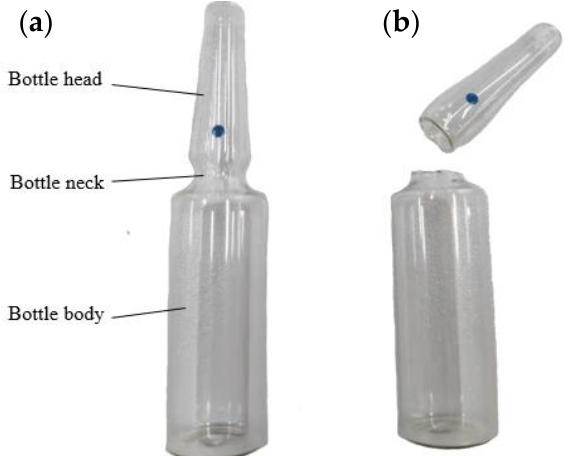
Figure 1. Pictures of the ampoule bottle and its broken parts on the neck. ( a ) Ampoule bottle. ( b ) Broken ampoule bottle.